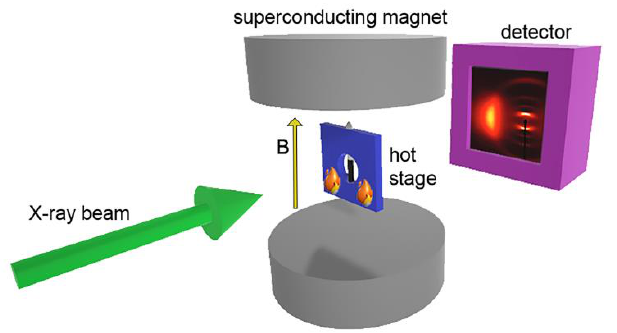
Figure 13. Experimental setup for XRD measurements on all-aromatic mesogens under a maximum magnetic field of 4 T. The hot stage allowed measurements up to 600 °C with a stability better than ± 0.5 °C.